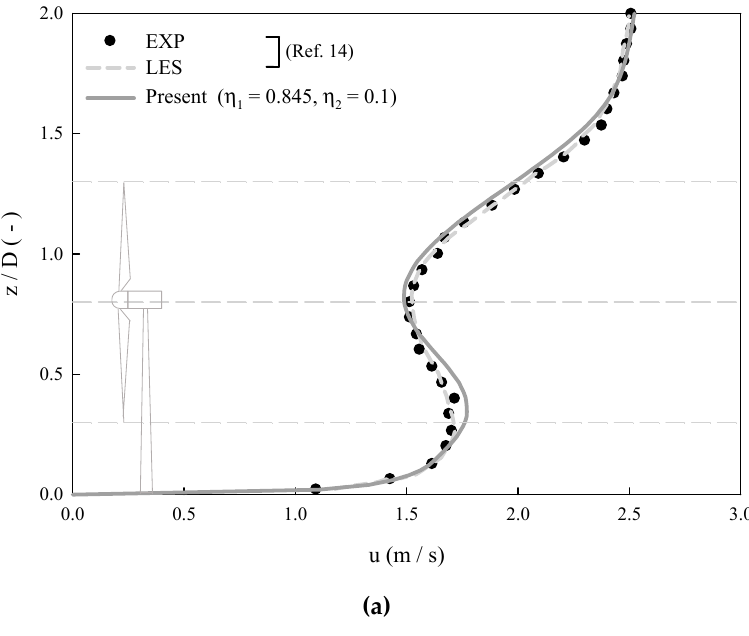
Figure 4. Mesh convergence test: ( a ) velocity profile; ( b ) average error of analysis and experiment data